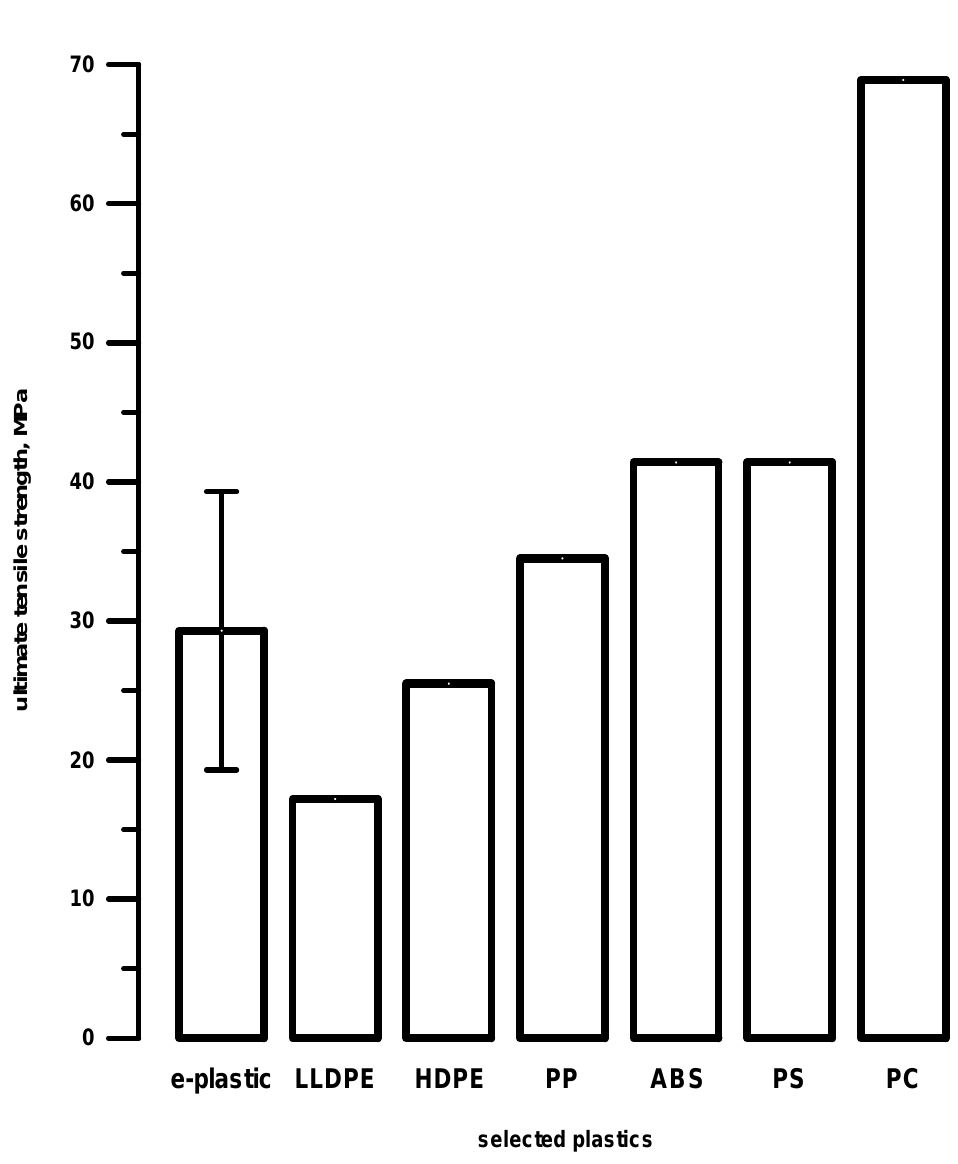
Figure 4. Comparative tensile strength of e-plastics from this study. Reference values for LLDPE, HDPE, PP, ABS, PS,g and PC are from Strong [65].